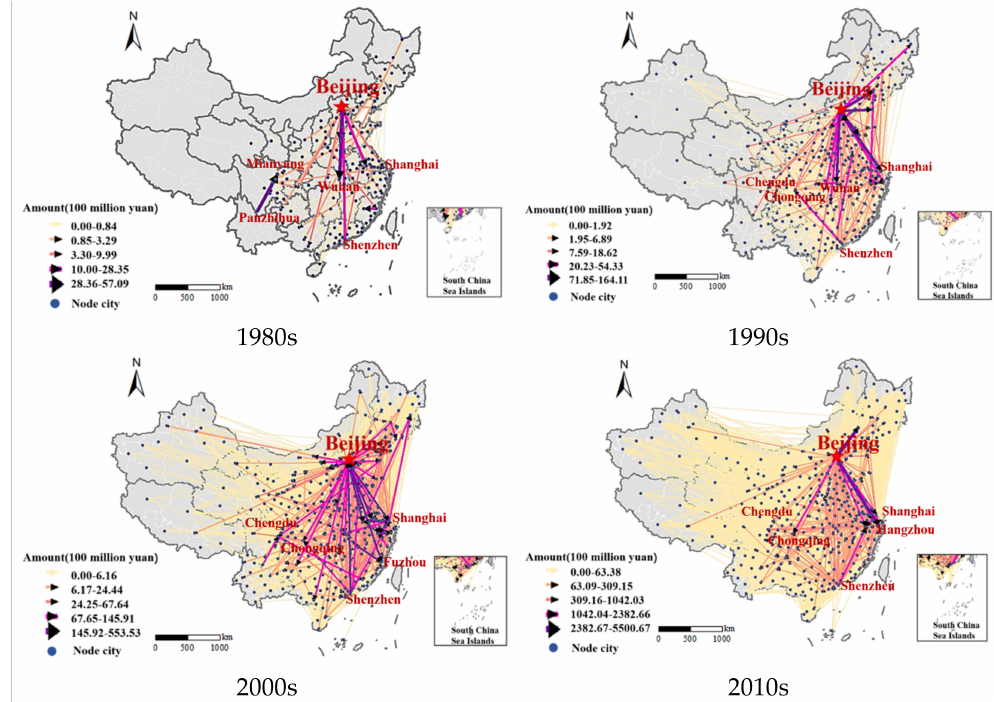
Figure 4. Spatial distribution of inter-city investment connections in four